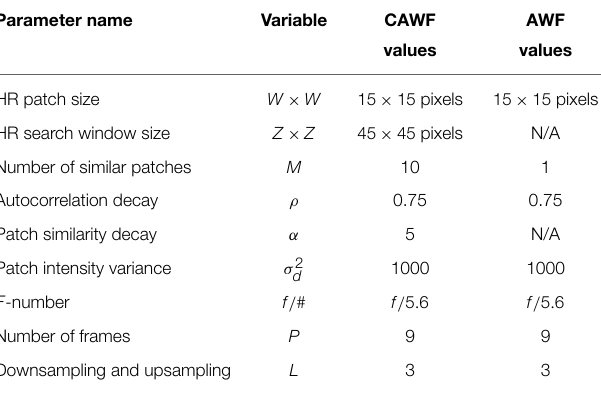
TABLE 2 | The AWF and the CAWF system parameters which are used for both real and simulated data results.